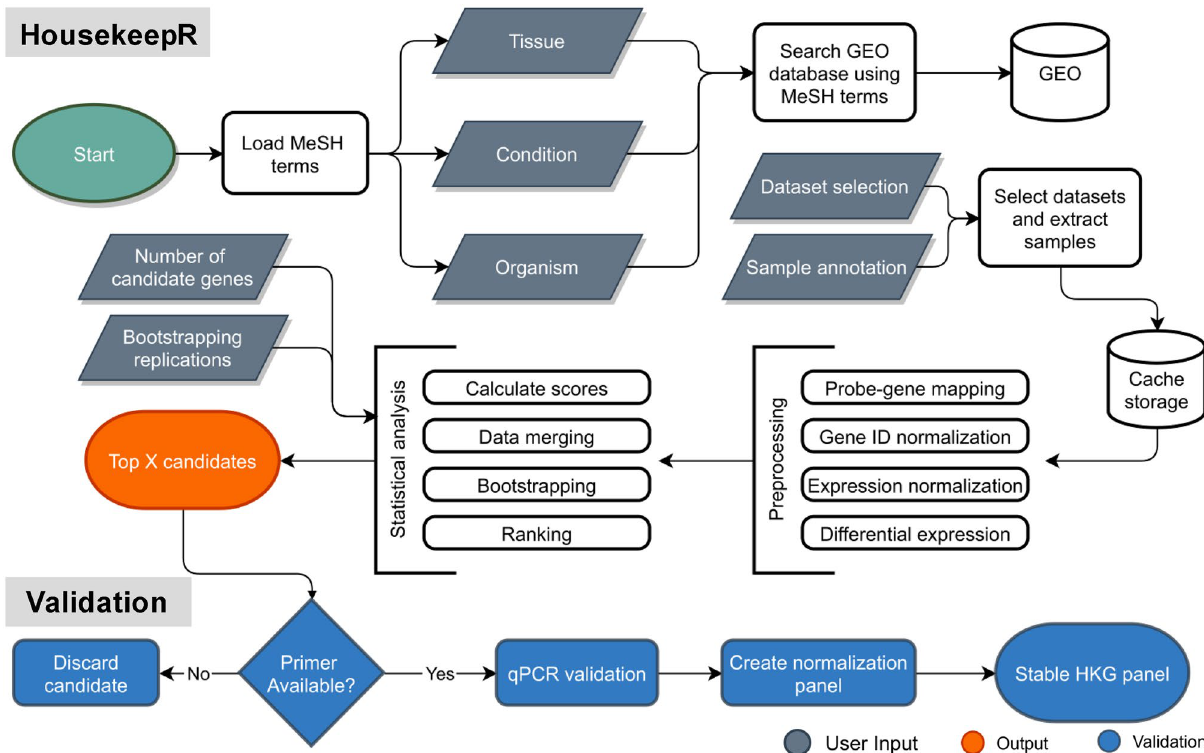
Figure 3. HouseKeepR algorithm flow chart. First, MeSH terms are parsed and preloaded to be used as standardised search terms for expressions data sets. User inputs for tissue, condition and organism, encoded in MeSH terms, are used to search and download data sets from Gene Expression Omnibus (GEO). The data sets are then pre-processed and statistically analysed using a scoring formula engineered to find normalisation genes. The top-ranking genes, based on user choice, are selected to be validated. In this scenario, normalisation genes within the first 25 ranked candidates were included in the subsequent validation process. Grey-colored elements show user required input, while the orange elements are the outputs of the user, and the blue elements are external validation steps conducted via wet-lab